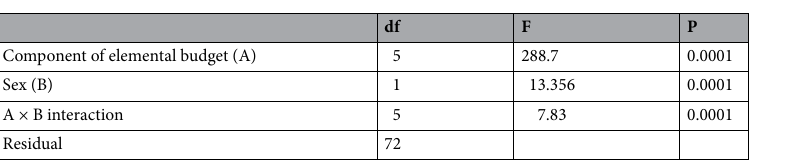
Table 1. In the red mason bee Osmia bicornis , the stoichiometry of 12 elements differed between components of the elemental budget (pollen loads, excreta, eggs, pupae, adults, cocoons), but the nature of these differences further was dependent on sex (significant A × B interaction). The results of two-way